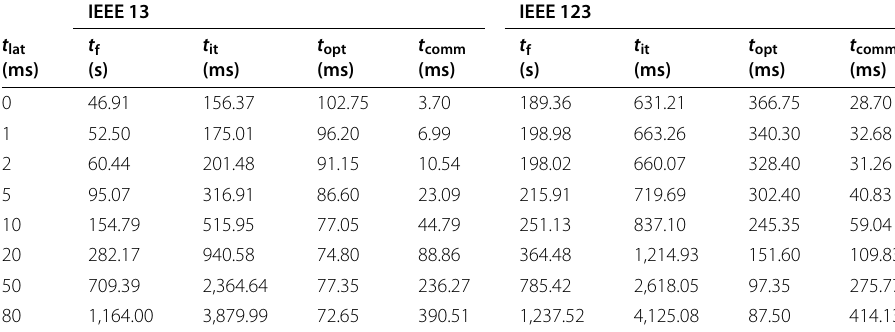
Table 2 Statistics for the time needed for convergence t f , the average iteration time t f , the average optimization time t opt , and the average roundtrip latency t f for different network filter latencies t